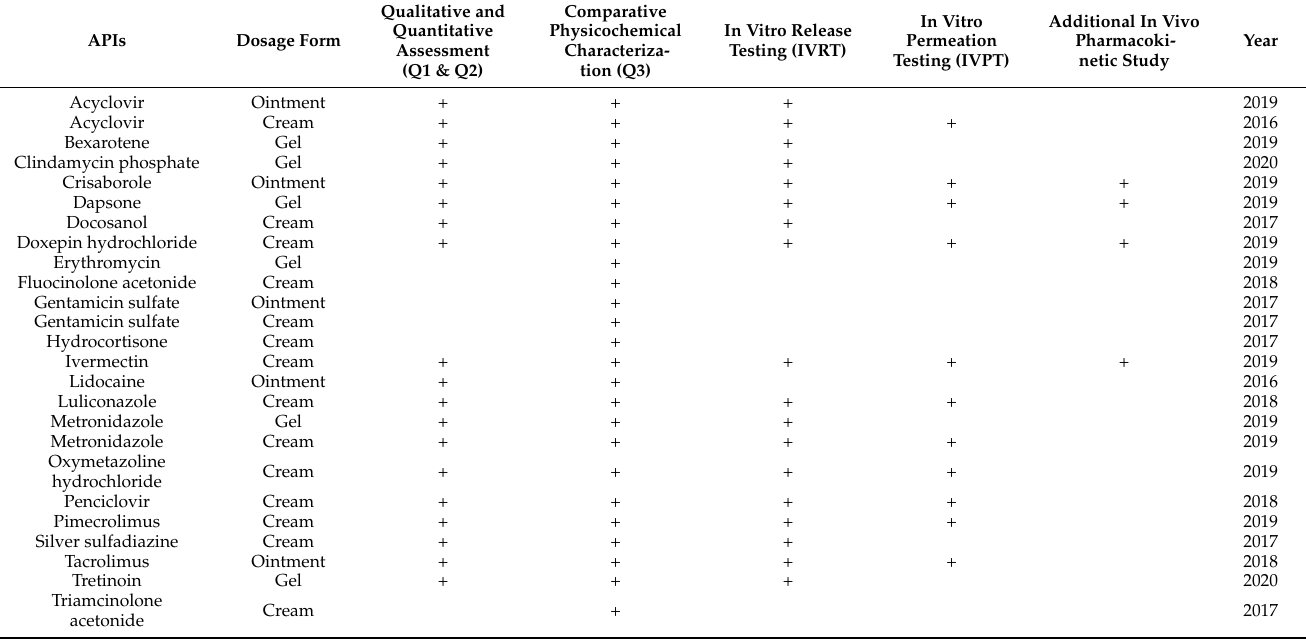
Table 1. The data were obtained from US FDA databases. List of APIs approved for topical drug products in semisolid dosage forms acquired from Orange Book: Approved Drug Products with Therapeutic Equivalence Evaluations before APIs filtered by the Product Specific Guidelines database for interrogation of in vitro characterization